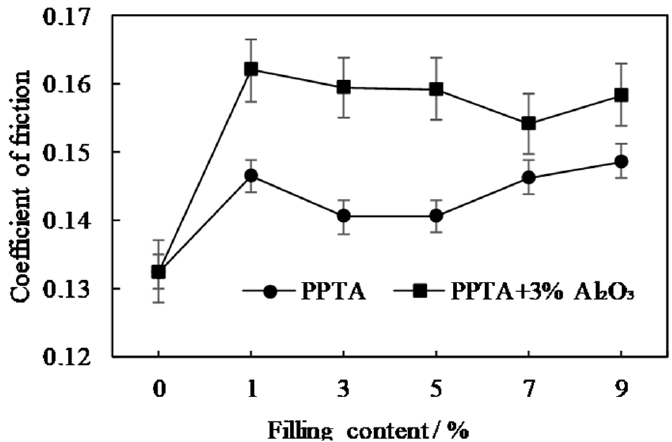
Figure 21. Wear coefficient of modified PTFE composite filled with PPTA and nano Al 2 O 3 particles.